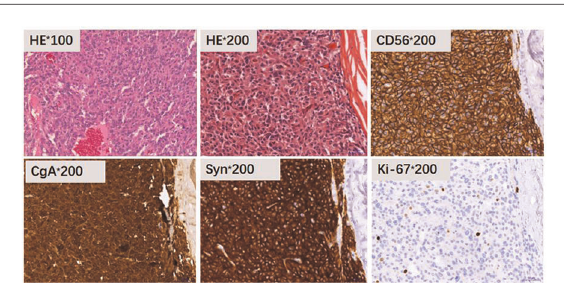
FIGURE 2 Pathology and immunohistochemistry showed HE staining of the tumor tissue (HE, 100× and 200×), CD56 (+), CgA (+), Syn (+), and Ki-67 index was